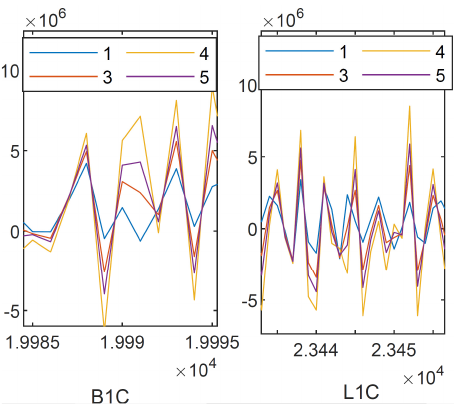
Figure 13. The amplitude of the noise data stream.